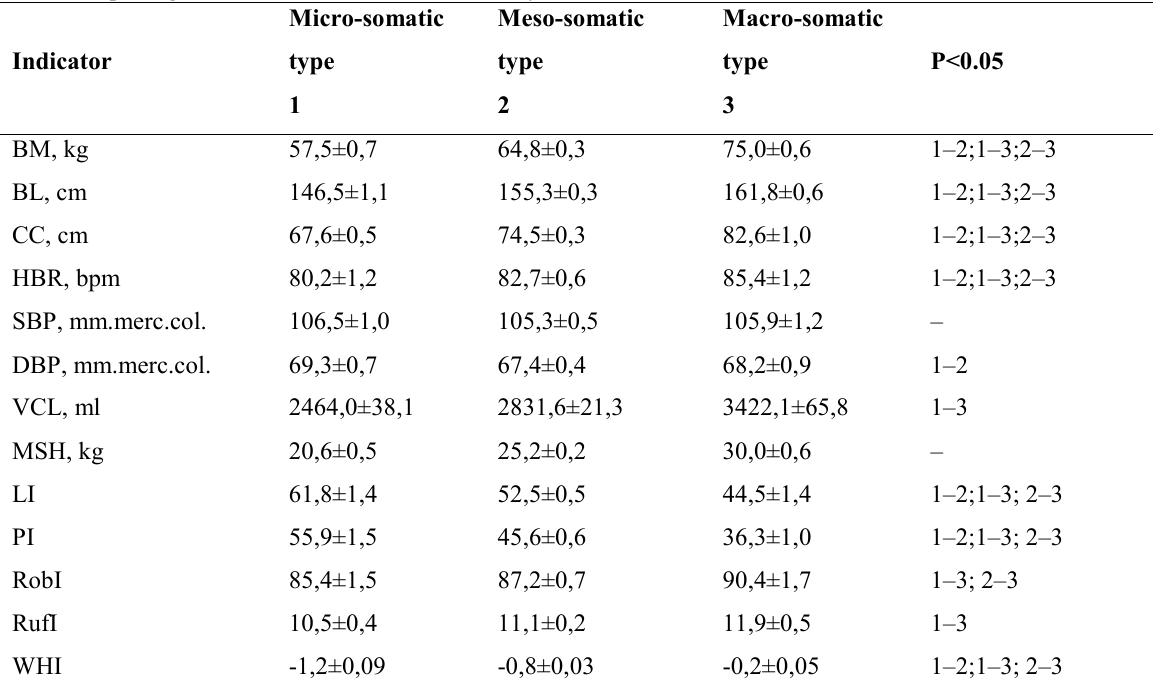
Table 1. Morphological-functional indicators of 17-22 years’ old